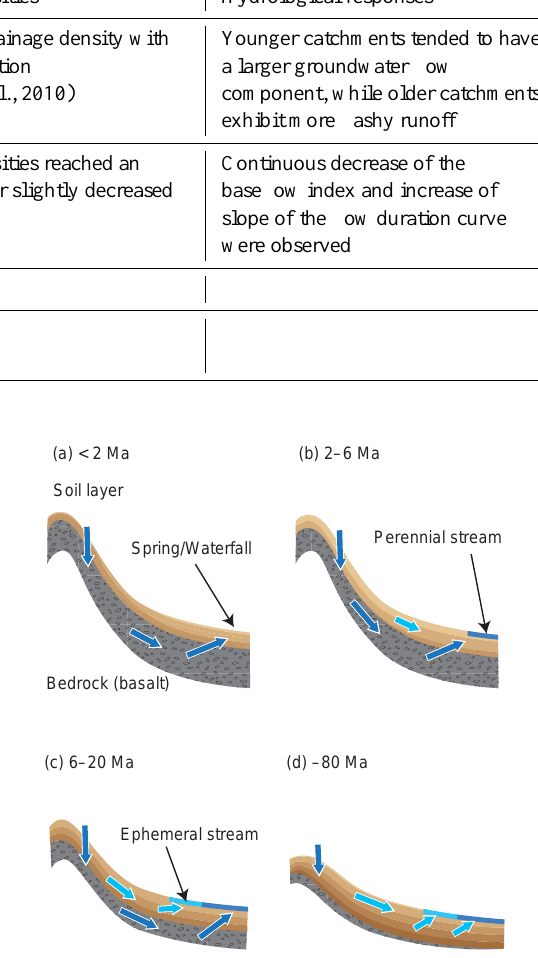
Table 4. Summary of hydrological and geomorphological analysis. Catchment age